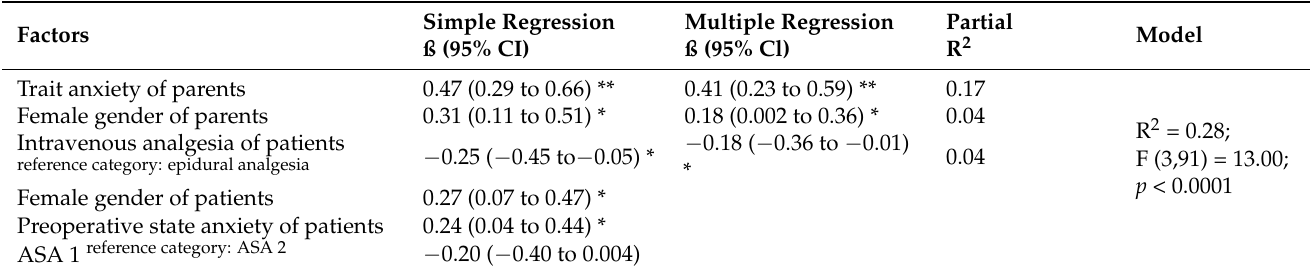
Table 4. Multiple linear regression analysis for variables predicting the preoperative state anxiety of parents.